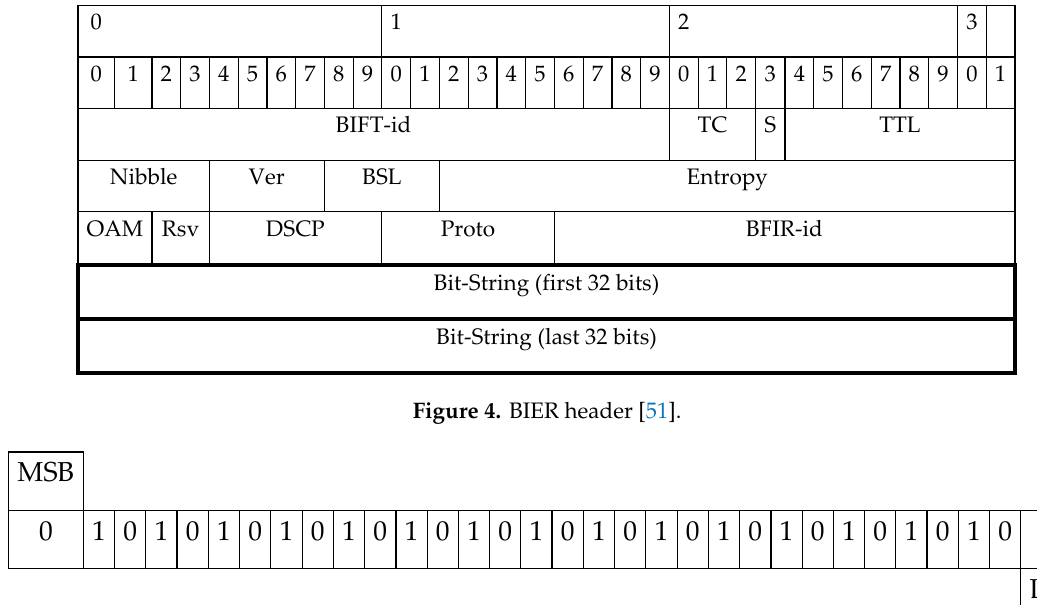
Figure 5. Bit-String. Figure 5.